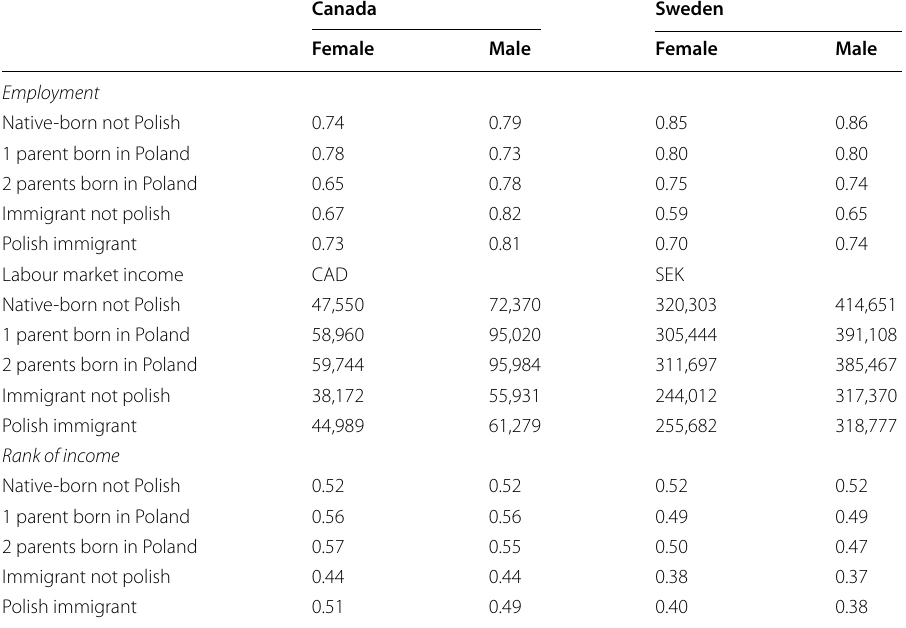
Table 3 Mean employment, market income and income rank for selected groups by country and sex